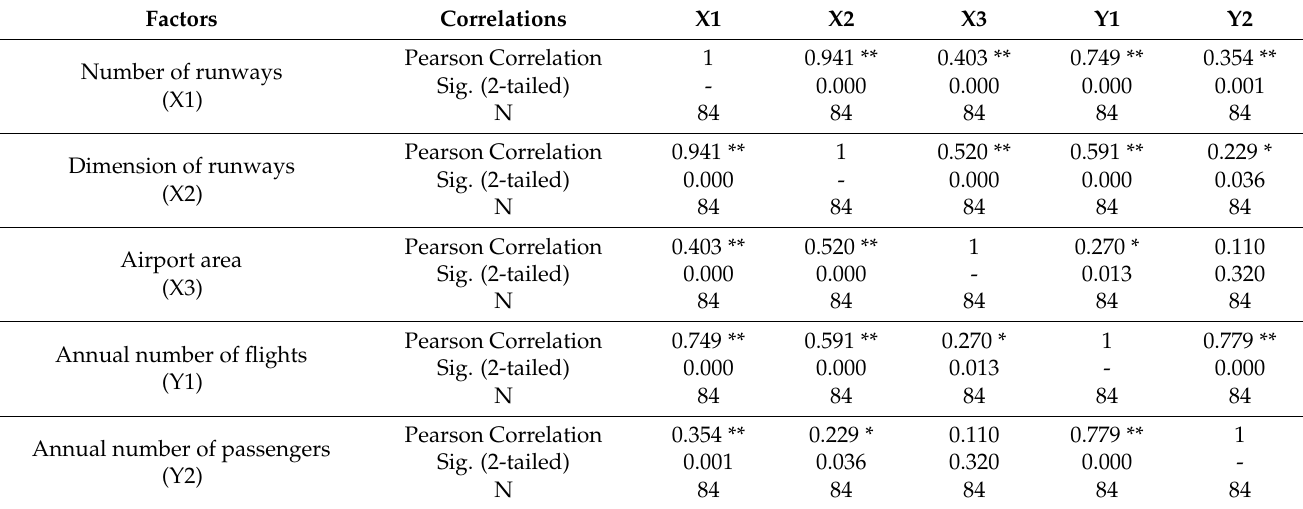
Table 5. The correlation matrix of input and output factors during